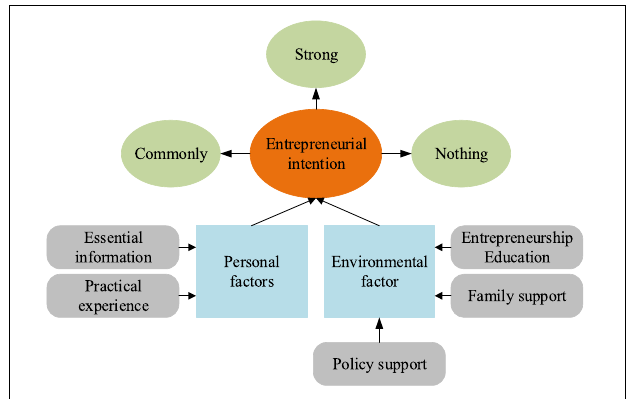
FIGURE 2 | Entrepreneurial event model.